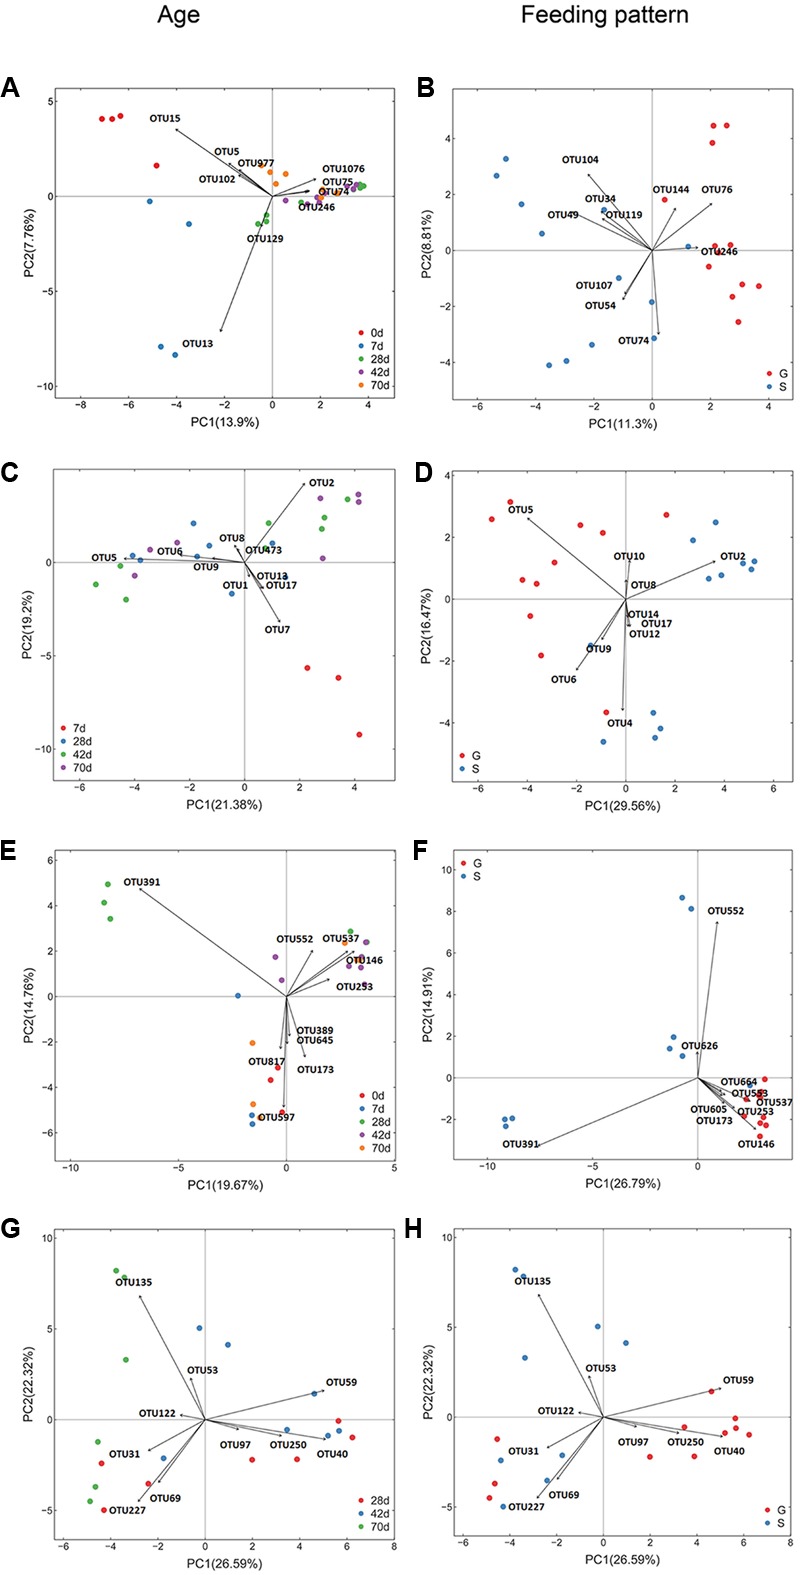
Transform-based PCA of each ruminal microbial domain for separation of different ages and feeding types in kids. The top 10 OTUs contributing to the separation of samples were displayed on the figure (OTU number). (A) Bacterial OTUs for discrimination of different ages, (B) Bacterial OTUs for discrimination of different feeding types. For bacteria (A,B), OTU15, Arcobacter genus; OTU5, Escherichia genus; OUT977, Escherichia genus; OTU102, Pasteurellaceae family; OTU13, Halomonadaceae family; OTU129, Delftia genus; OTU74, Prevotella genus; OTU75, Lachnospiraceae family; OTU1076, Prevotella genus; OTU246, Prevotella genus; OTU76, Prevotella genus; OTU144, Prevotella genus; OTU104, Succinivibrionaceae family; OTU34, Prevotella genus; OTU49, Prevotella genus; OTU119, Bacteroidales order; OTU107, Succinivibrionaceae family; OTU54, Ruminococcaceae family. (C) Archaeal OTUs for discrimination of different ages, (D) Archaeal OTUs for discrimination of different feeding types. For archaea (C,D), OTU5, Methanomassiliicoccaceae family; OTU2, Mbb. gottschalkiiclade; OTU7, Archaea domain; OTU6, Group12_sp._ISO4-H5; OTU9, Group9_sp._ISO4-G1; OTU8, Mbb. Ruminantium clade; OTU4, Methanomassiliicoccaceae family; OTU1, Group10_sp.; OTU10, Mbb. acididurans clade; OTU12, Mbb. mobile clade; OTU13, Euryarchaeota phylum; OTU14, Euryarchaeota phylum; OTU17, Archaea domain; OTU473, Mbb. Ruminantium clade. (E) Fungal OTUs for discrimination of different ages, (F) Fungal OTUs for discrimination of different feeding types. For fungi (E,F), OTU391, Neocallimastix genus; OTU579, Saccharomyces genus; OTU146, Uwebraunia genus; OTU537, Piromyces genus;OTU173, Boeremia genus; OTU817, unclassified fungi; OTU645, Eupenicillium genus; OTU552, Piromyces genus; OTU253, Knufia genus; OTU389, Neurospora genus; OTU553, Neocallimastix genus; OTU664, Microcyclosporella genus; OTU626, Sarocladium genus; OTU605, Neocallimastixgenus. (G) Protozoal OTUs for discrimination of different ages, (H) Protozoal OTUs for discrimination of different feeding types. For protozoa (G,H), OTU135, Polyplastron genus; OTU40, Epidinium genus; OTU59, Entodinium genus; OTU227, Entodinium genus; OTU69, Entodinium genus; OTU50, Eremoplstron-Diploplastron genus; OTU31, Entodinium genus; OTU53, Anoplodinium–Diplodinium; OTU97, Epidinium genus; OTU122, Polyplastron genus.